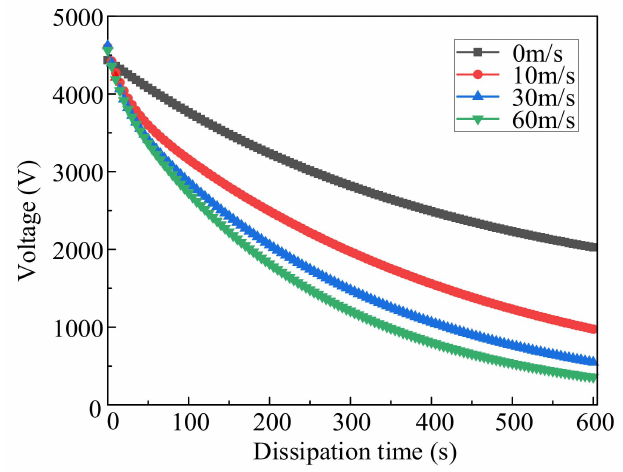
Figure 19. Time dissipation curves for positive polarity charge.